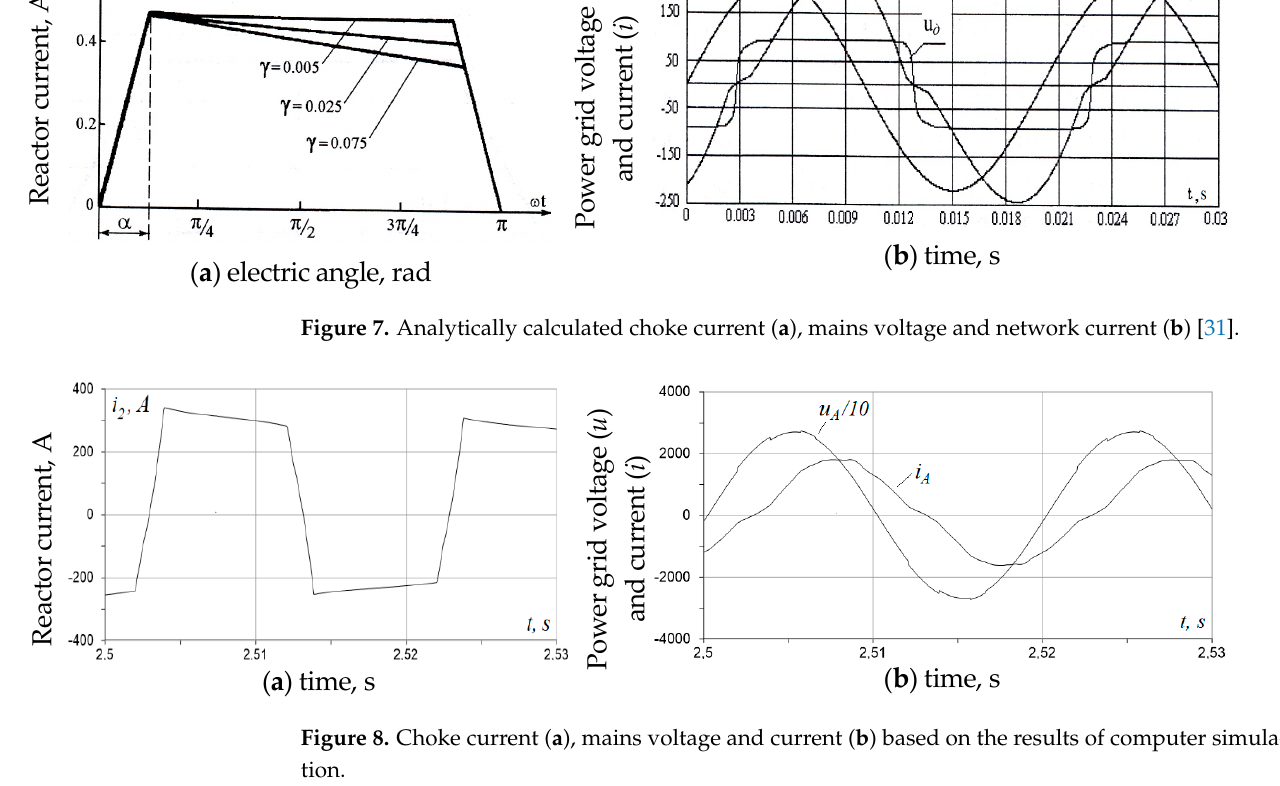
Figure 9. Structural–functional diagram of the electrode movement system. The movement of the electrodes is carried out by a DC electric drive. In conducting research, we used the impedance control principle, according to which the control signal in the electric drive is boosted based on the current values. I arc and arc voltage U arc are calculated by the equations arc